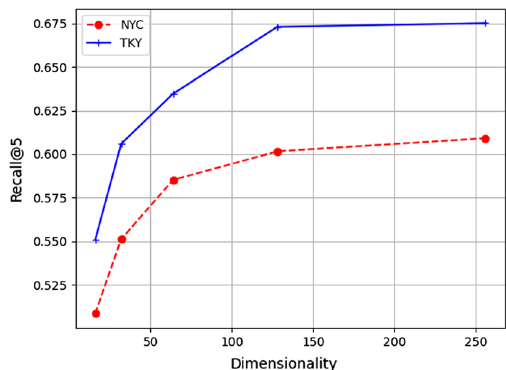
Fig. 4 Recall@5 value with varying hidden dimensionality of model on two datasets